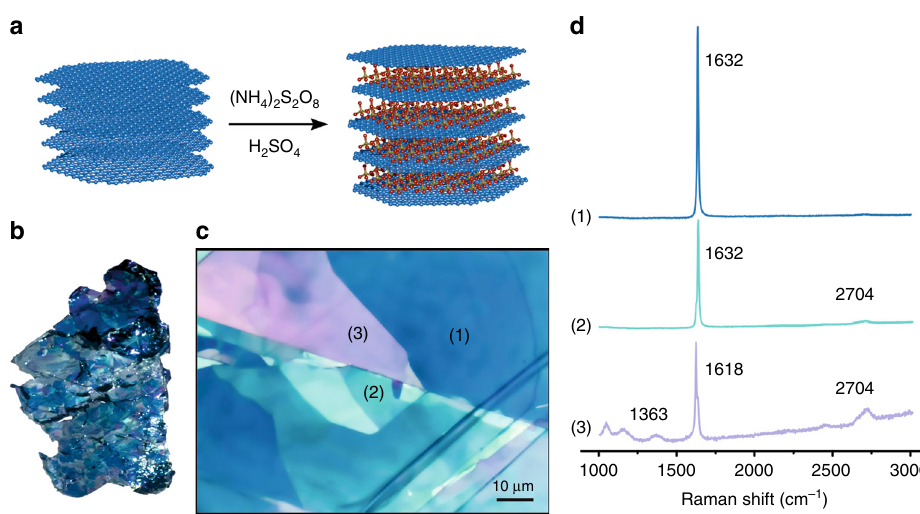
Fig. 2 Intercalation of highly crystalline graphite. a Illustration of the reaction of ideally AB-stacked graphite with ammonium persulfate in sulfuric acid forming stage-1 graphite sulfate. b Optical image of a treated natural fl ake of graphite for one month and c microscopy image with dark blue areas (1) that can be related to stage-1 graphite sulfate and other regions lighter in color indicating that stage-1 formation is hindered (2,3). d Raman spectra of area 1, 2, and 3. See also Supplementary